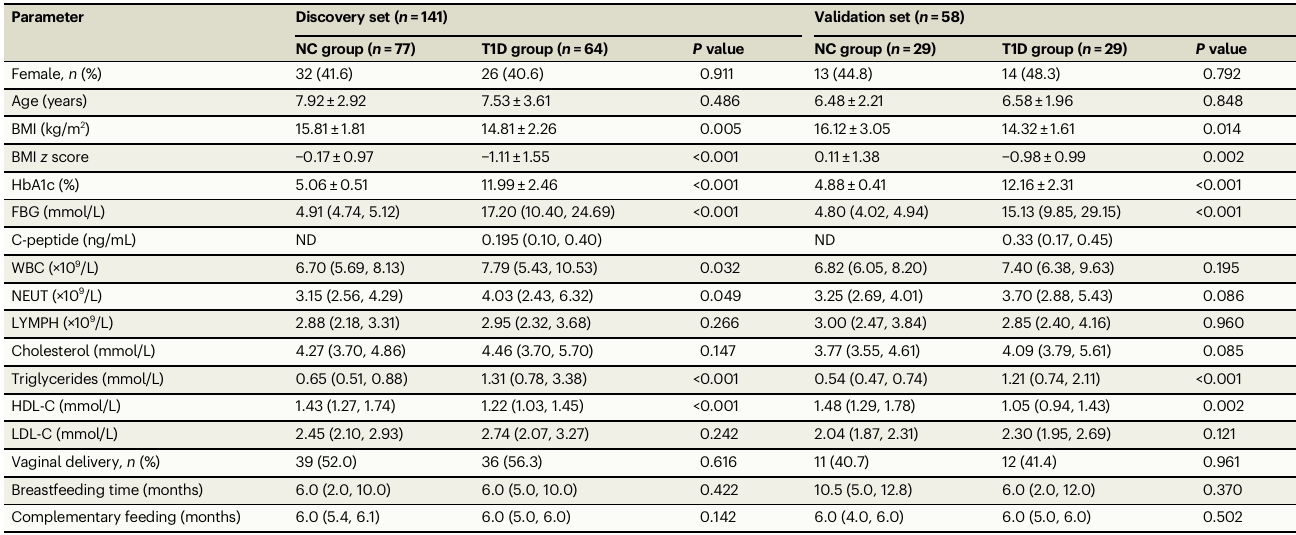
Dataarepresentedasmean±standarddeviation(SD),medianwithinterquartilerange(IQR),or n (%).The p valuesarebasedonthetwo-sided t testforvariablesexpressedasmean±SD,Wilcoxon rank-sumtestforvariablesexpressedasmedian(IQR)andchi-squareTestforvariablesexpressedaspercentages.NCvsT1Dgroup. NC normalcontrol, T1D type1diabetes, ND notdetermined, BMI bodymassindex, HbA1c hemoglobinA1c, FBG fastingbloodglucose, WBC whitebloodcell, NEUT neutrophil, LYMPH lymphocytes, HDL-C high-densitylipoprotein, LDL-C